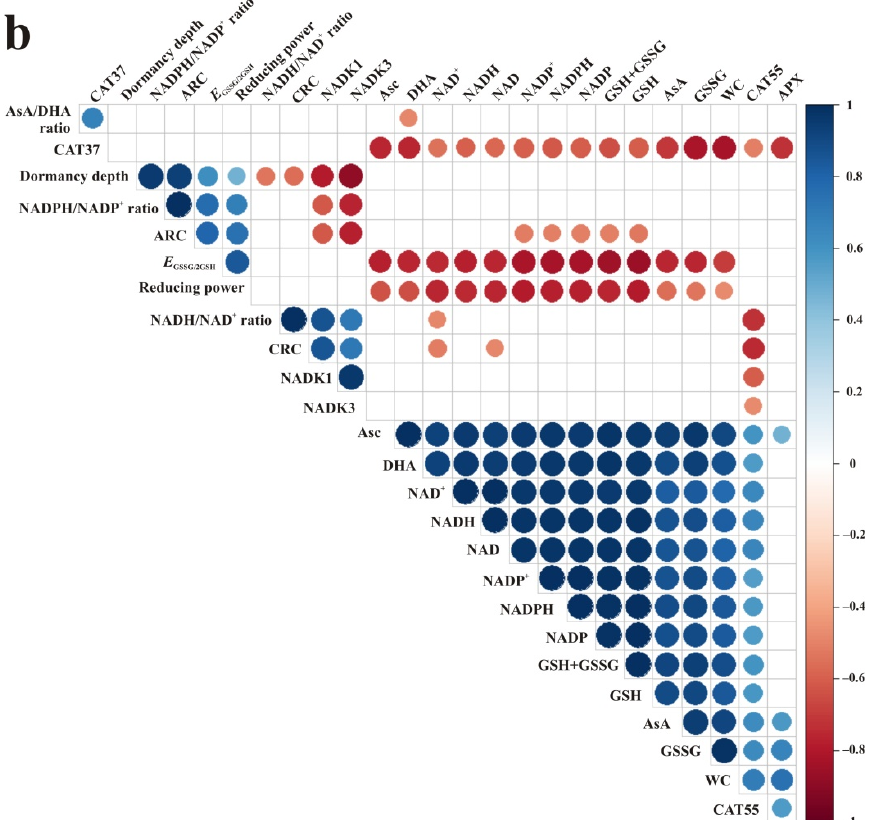
Figure 7. Heatmaps of correlation matrices determined for embryonic axes ( a ) and cotyledons ( b ) of developing beech seeds calculated between levels of ascorbate (Asc), ascorbic acid (AsA), dehydroascorbate (DHA), reduced (GSH) and oxidized (GSSG) glutathione, half-cell reduction potential of glutathione ( E GSSG/2GSH ), contents of nicotinamide dinucleotide (NAD) phosphate (NADP) redox forms and their ratios, anabolic redox charge (ARC), catabolic redox charge (CRC), dormancy depth, phosphorylation capacity of isoform 1 (NADK1) and isoform 3 (NADK3) of NAD kinase and reducing power, and abundance of ascorbate peroxidase (APX) and catalases (CAT37, CAT55). Proportional data were arcsine transformed. Color intensity and the size of the circle are proportional to the correlation coefficients. Blanks indicate nonsignificant correlations ( p > 0.05).